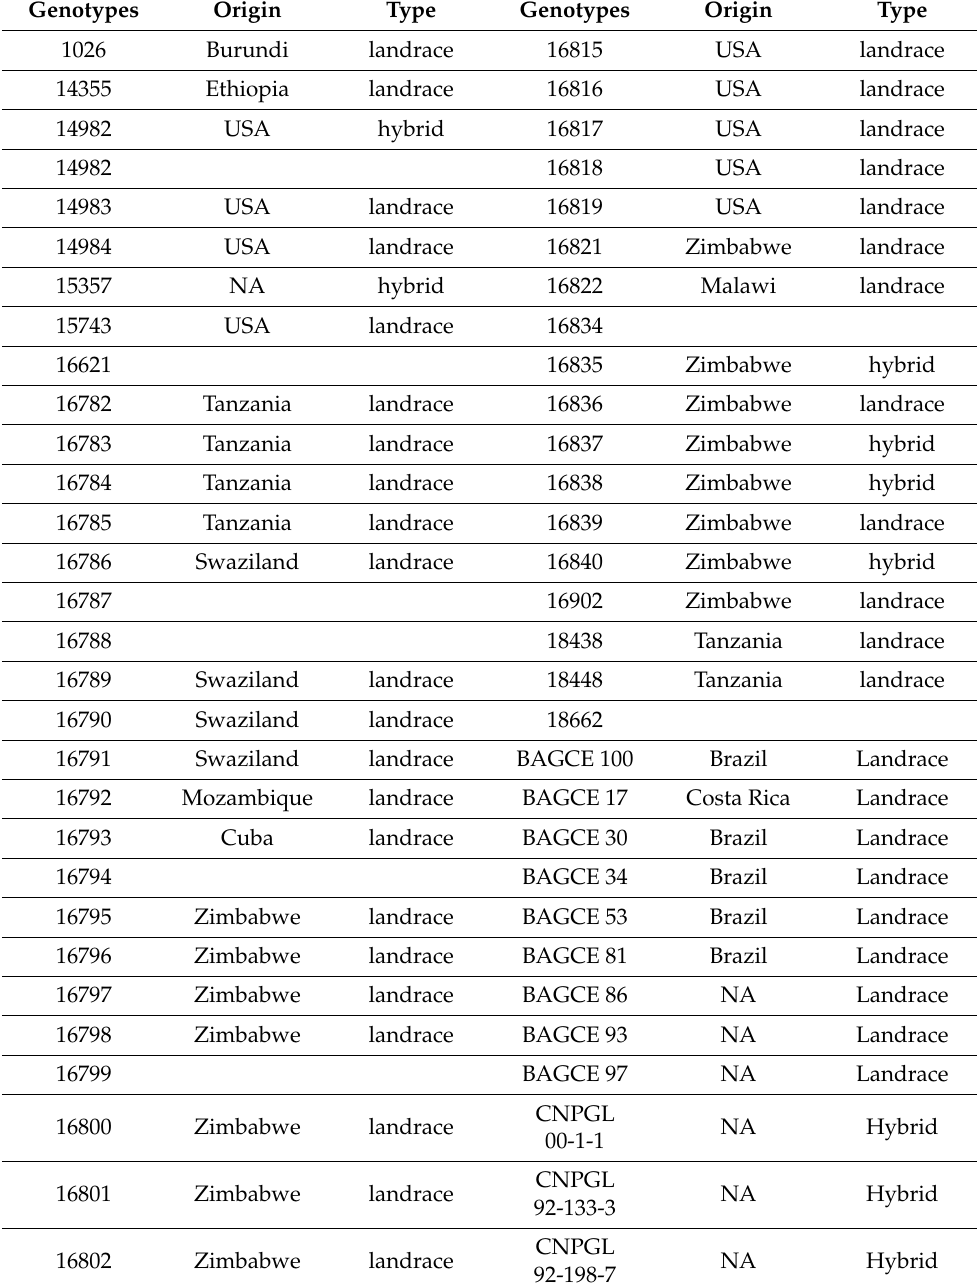
Table A1. Experimental genotypes used for the